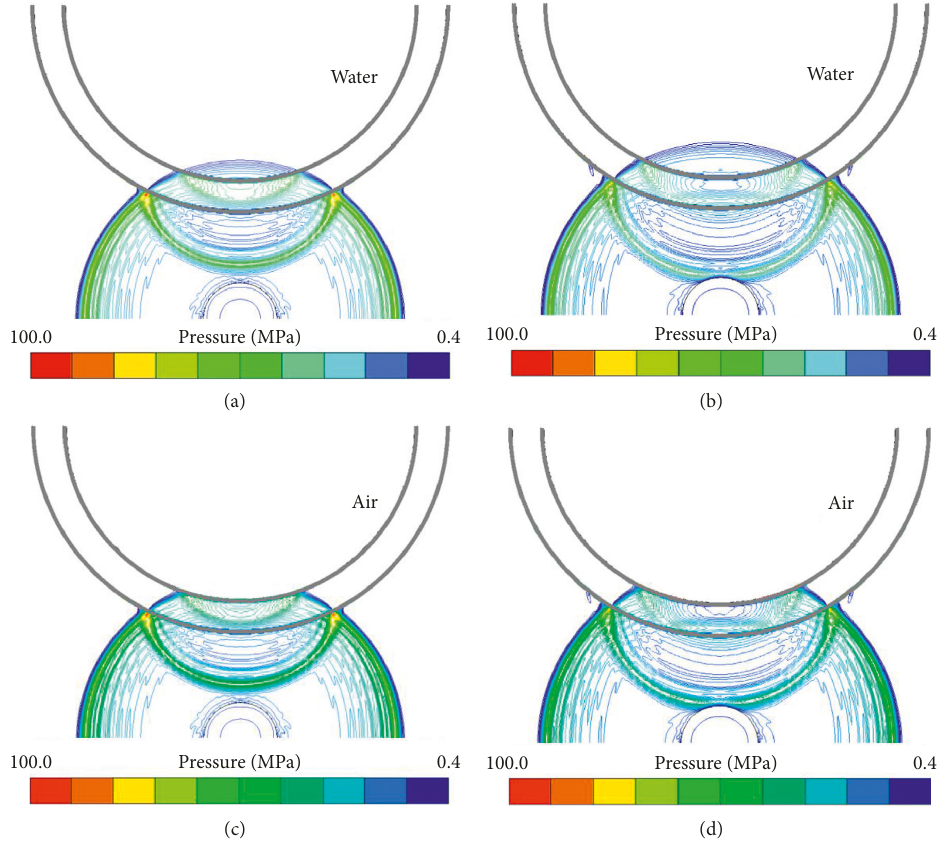
Figure 17: The pressure contours if the medium is water-water and water-air at the same time. (a) Water-water at t � 6 . 30 θ . (b) Water-water at t � 7 . 09 θ . (c) Water-air at t � 6 . 30 θ . (d) Water-air at t � 7 . 09 θ